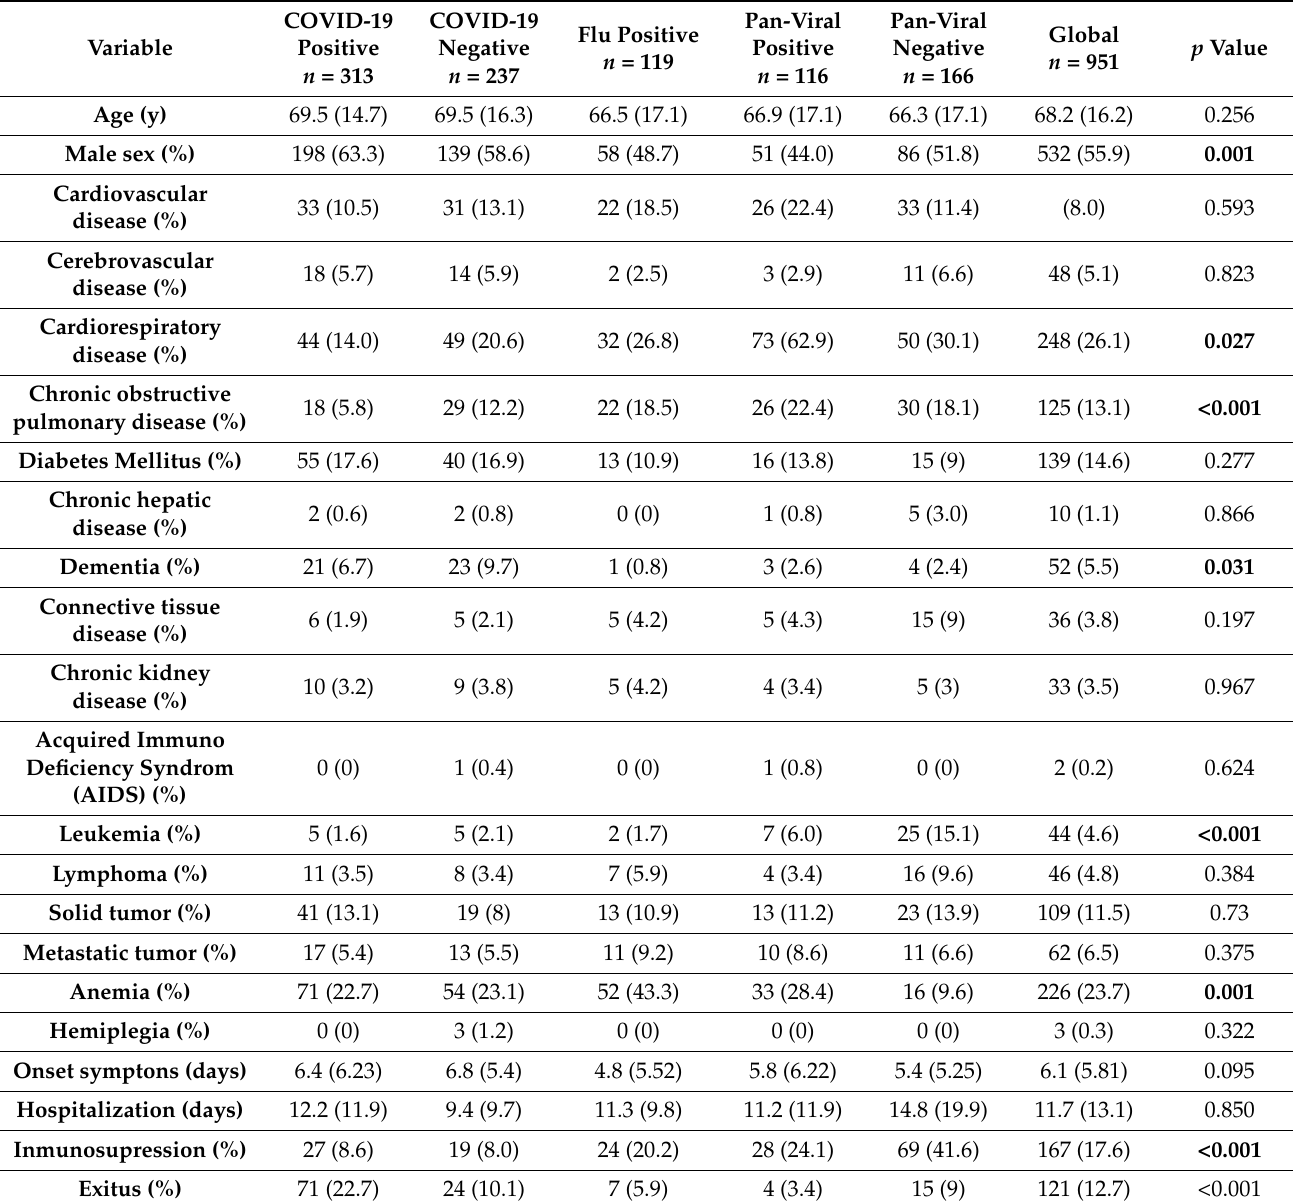
Table 1. Clinical and phenotypical characteristics of subjects included in this cohort, categorized according to the PCR results for different respiratory